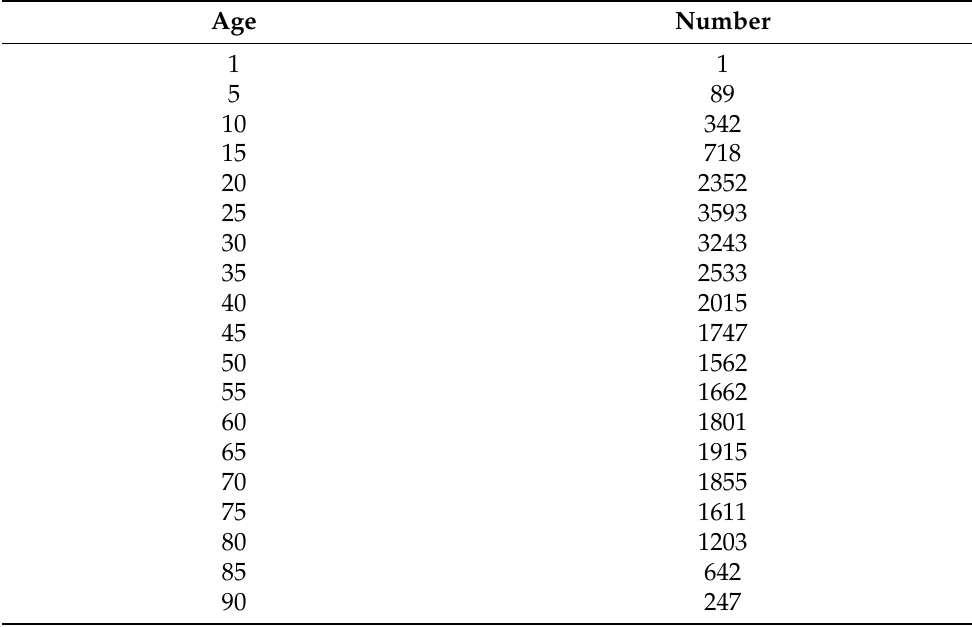
Table A1. Data corresponding to Kaposi’s